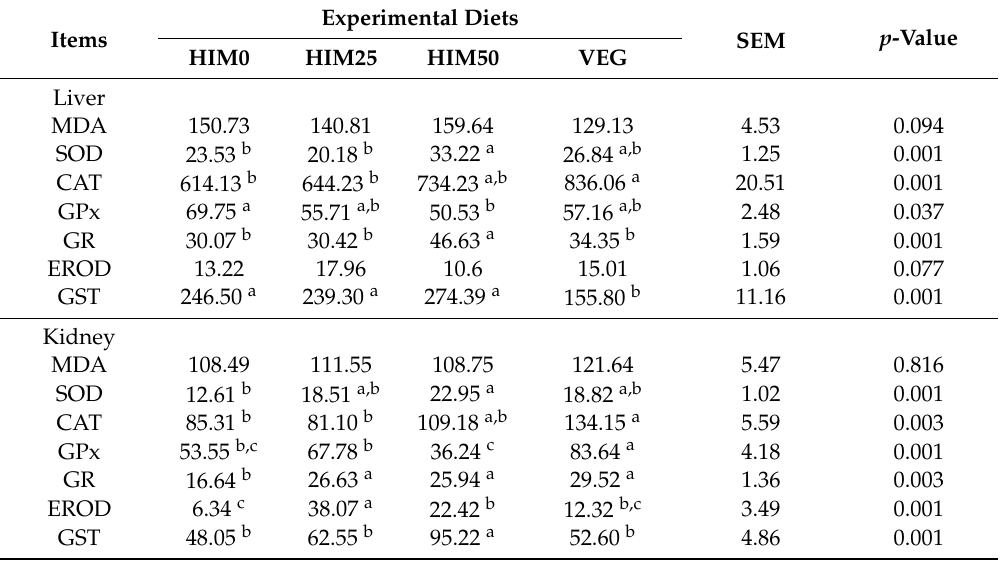
Table 5. E ff ects of dietary H. illucens larva meal inclusion and vegetable protein based diet on oxidative stress biomarkers in liver and kidney of